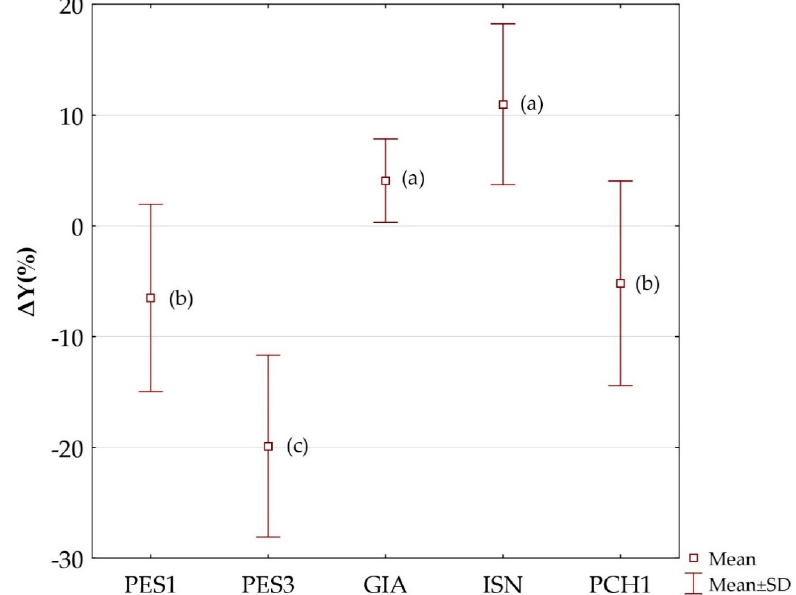
Figure 7. Whisker plots of the mean yield variation, ∆ Y(%) of three years, related to soil typological